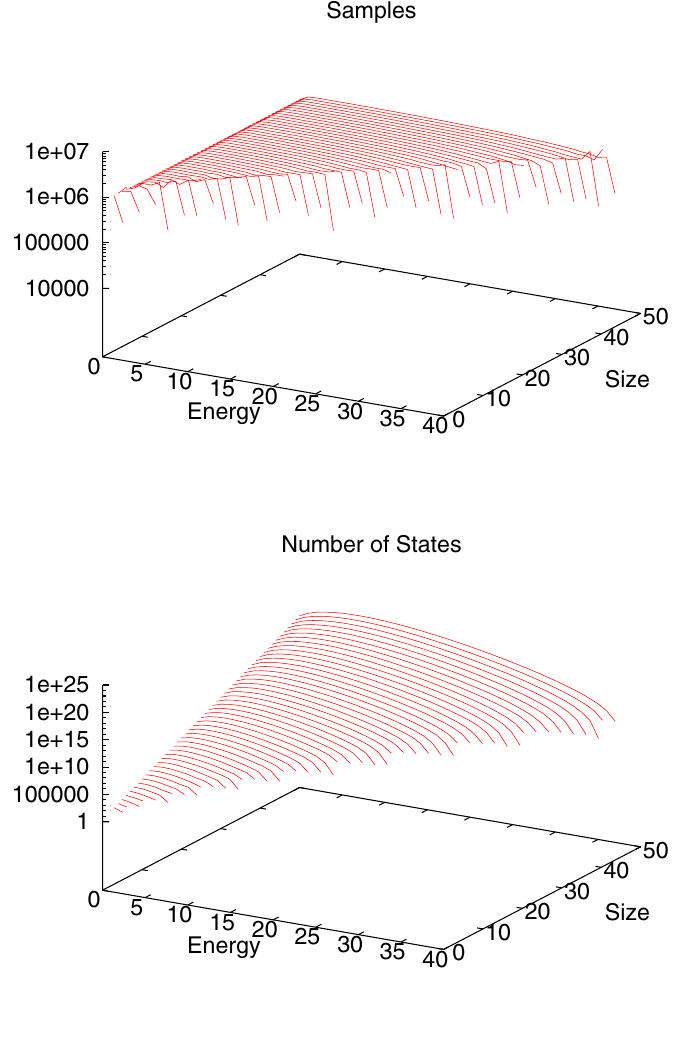
Fig. 7. Interacting Self-Avoiding Walks with up to 50 steps generated with flatPERM. The upper figure shows that a roughly constant number of samples is obtained across the whole range of sizes and energies, and the lower figure shows the estimated number of states for a given Size n and Energy m